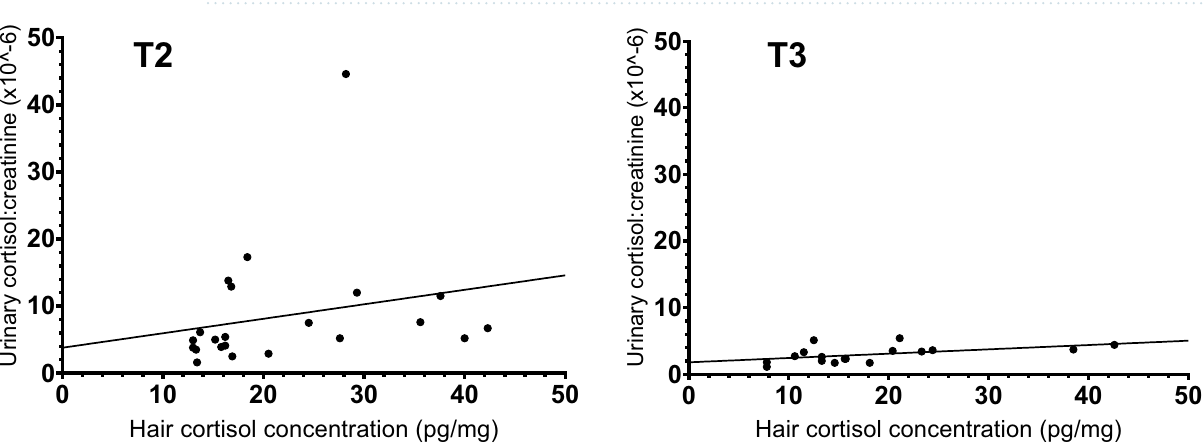
Figure 2. Hair cortisol concentration (pg/mg, original values) at different sample collection moments (T1-4). For ( a ) shelter dogs (“bullet”, total n = 52) and pet dogs (“red triangle”, n = 20), and ( b ) selection of the shelter dogs with an available sample on T2 (6 weeks in-shelter, n = 23), this is only the subset of dogs that were not yet adopted at T2, where the other dogs were not in the shelter anymore. N.B. Individual responses are connected with lines but do not imply continuous sampling.